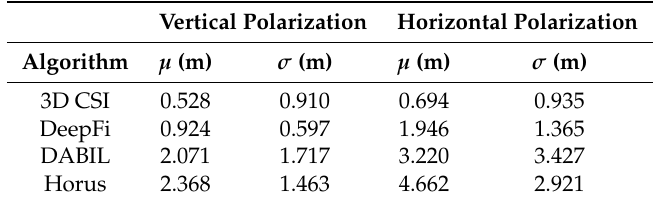
Figure 6. Localization comparison between the proposed 3D CSI approach with other approaches prescribed in the IPS literature. Table 2. Localization Performances of Different IPS